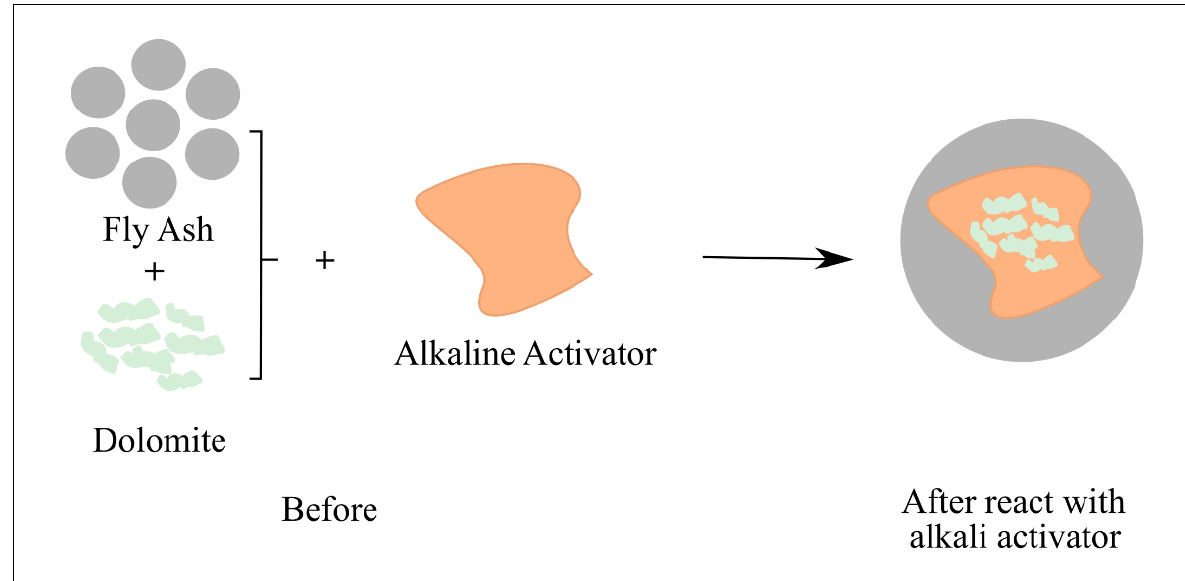
Figure 8. Schematic diagram of the reaction between fly ash and dolomite geopolymer.